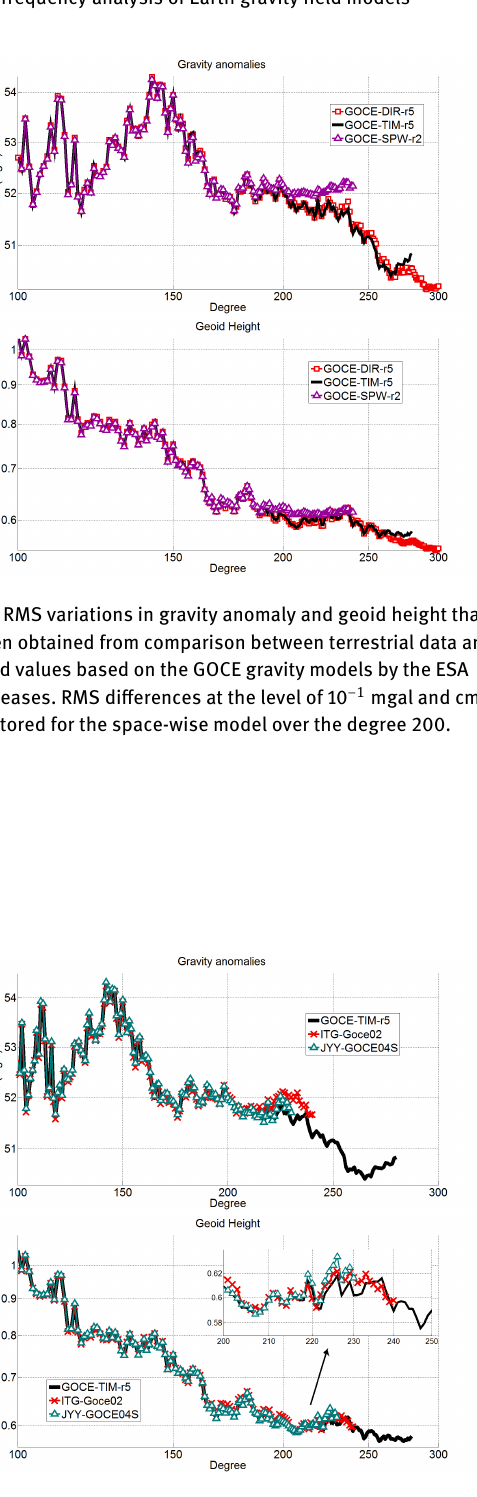
Figure 6: RMS variations in gravity anomaly and geoid height that have been obtained from comparison between terrestrial data and computed values based on GOCE-only extracted gravity models. RMS differences are captured over the degree